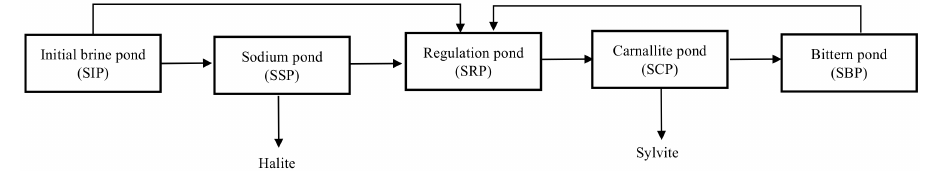
Figure 2. Scheme for the solar pond from Salt Lake